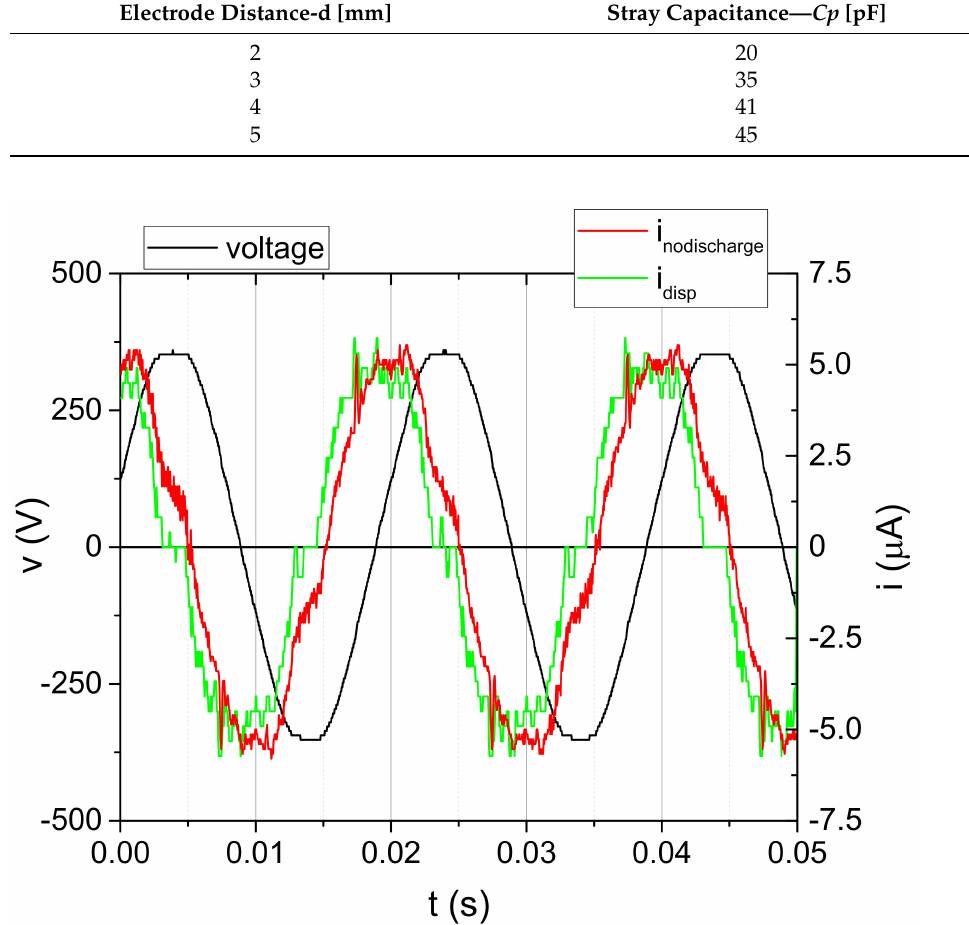
Figure 5. Waveforms of voltage (black line) and current (red line) obtained for d = 5 mm without discharge (input voltage V input = 6 V). Displacement current (green line) is calculated by using voltage signal (Equation